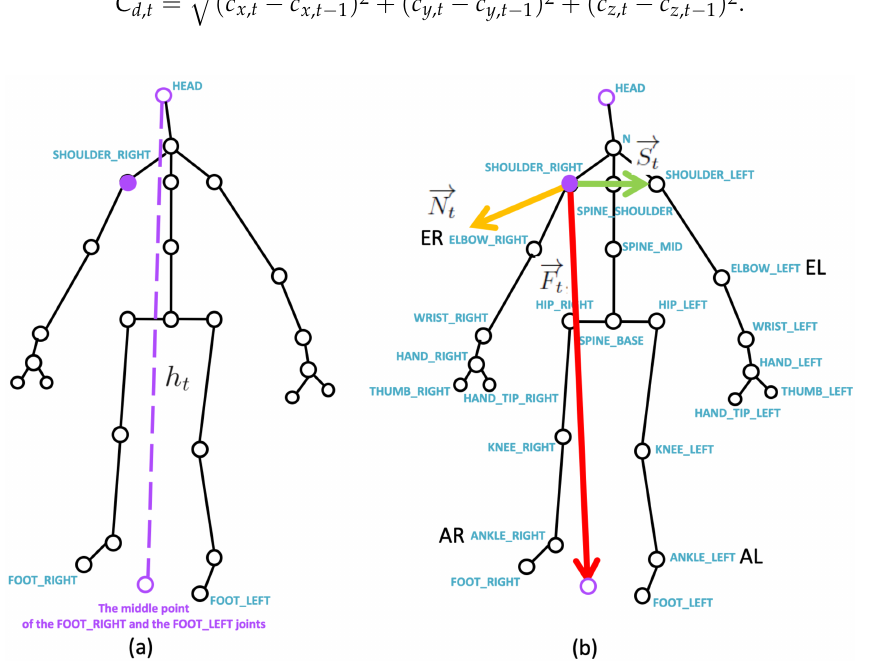
Figure 3. The joints according to Kinect SDK: ( a ) the normalization factor of the body height in each frame, and ( b ) the basis vectors for time-variant skeleton vector